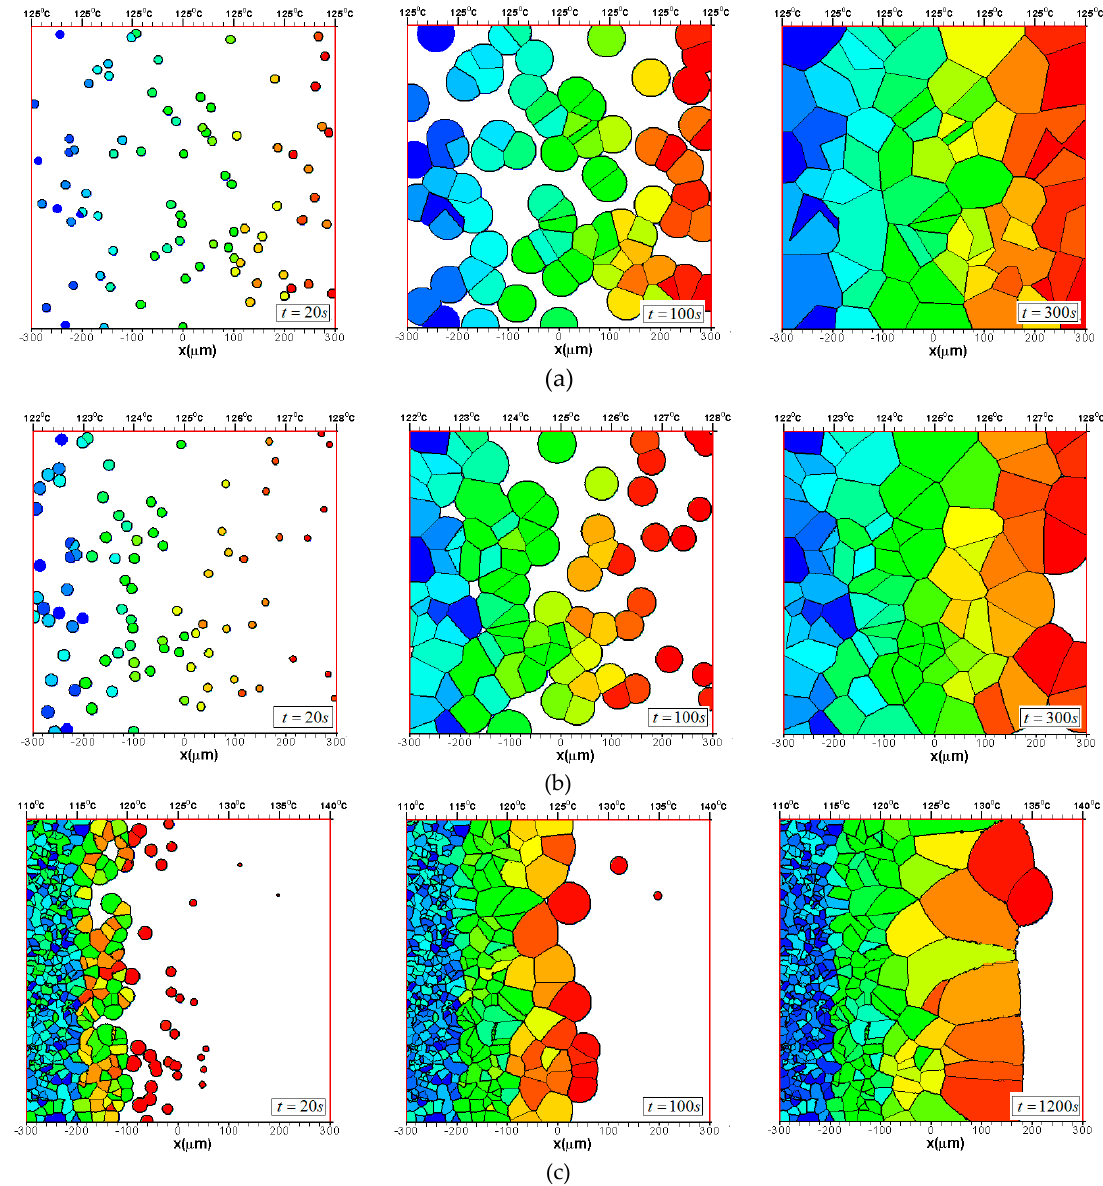
Figure 7. Morphology evolution with the central temperature Figure7. Morphologyevolutionwiththecentraltemperature T